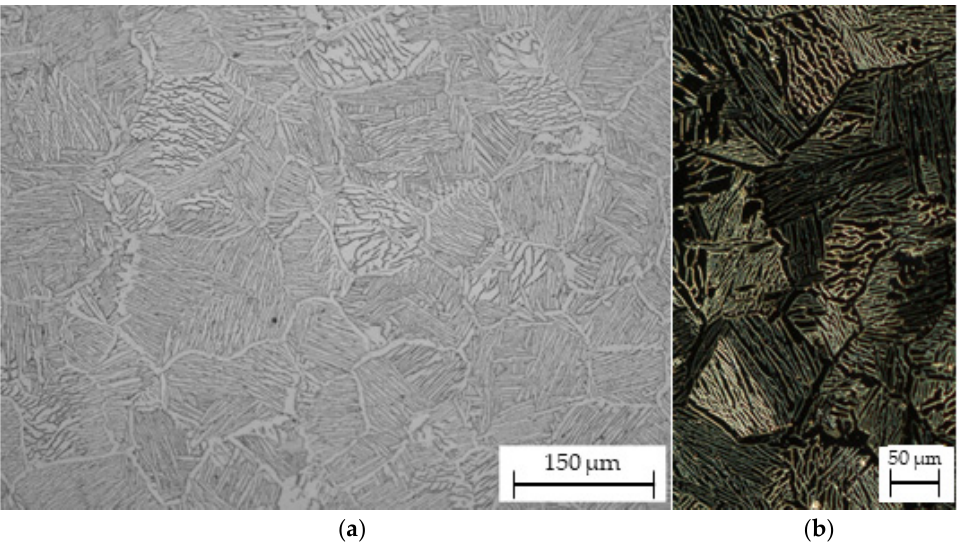
Figure 4. Fully lamellar microstructure attained after HT-A (furnace cooling from 955 ◦ C) ( a ) overall appearance ( b ) morphology of individual α platelets and retained β phase